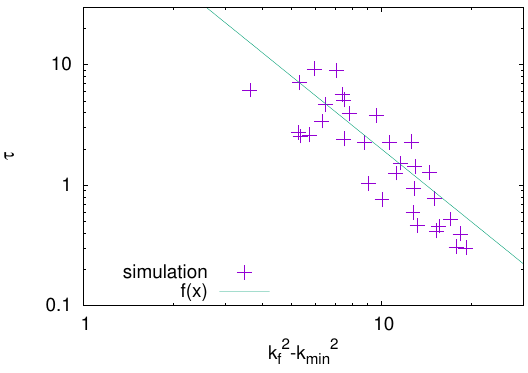
− k 2 , where k f and k min denote the wavenumber of min f